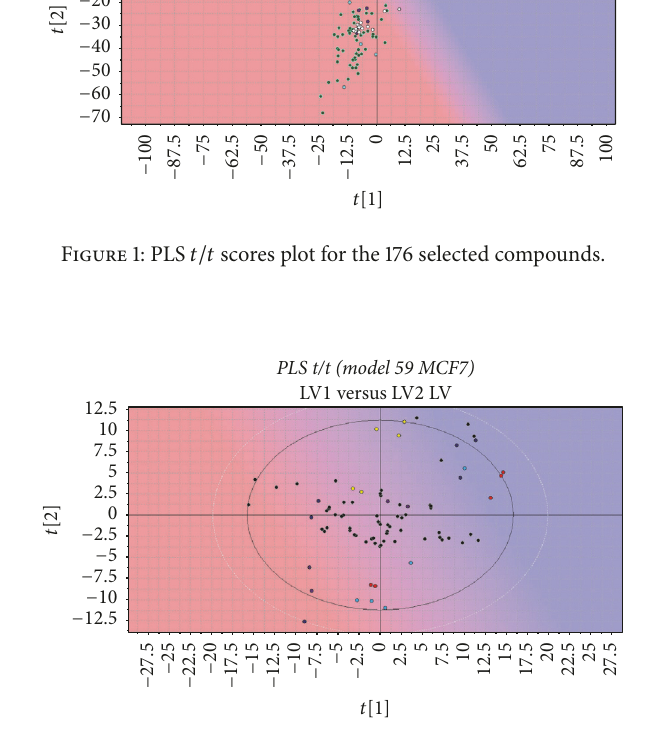
while the MDA-MB-231 is oestrogen receptor-negative unre- sponsive to the same